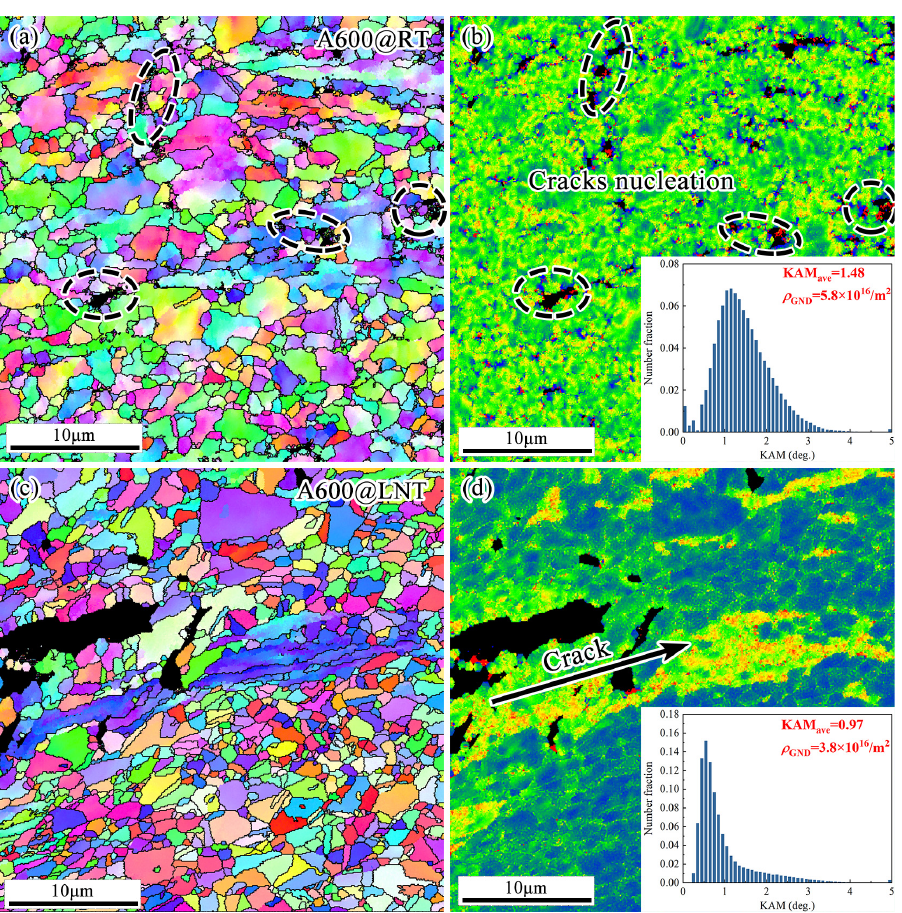
Figure 7. EBSD characterization of deformed microstructure underneath fracture surface of A600 Charpy V-notch impact specimen at ( a , b ) RT and ( c , d ) LNT. ( a , c ) IPF maps. ( b , d ) Corresponding KAM maps and statistical KAM data (see insets). The dotted circles point to the crack nucleation sites.